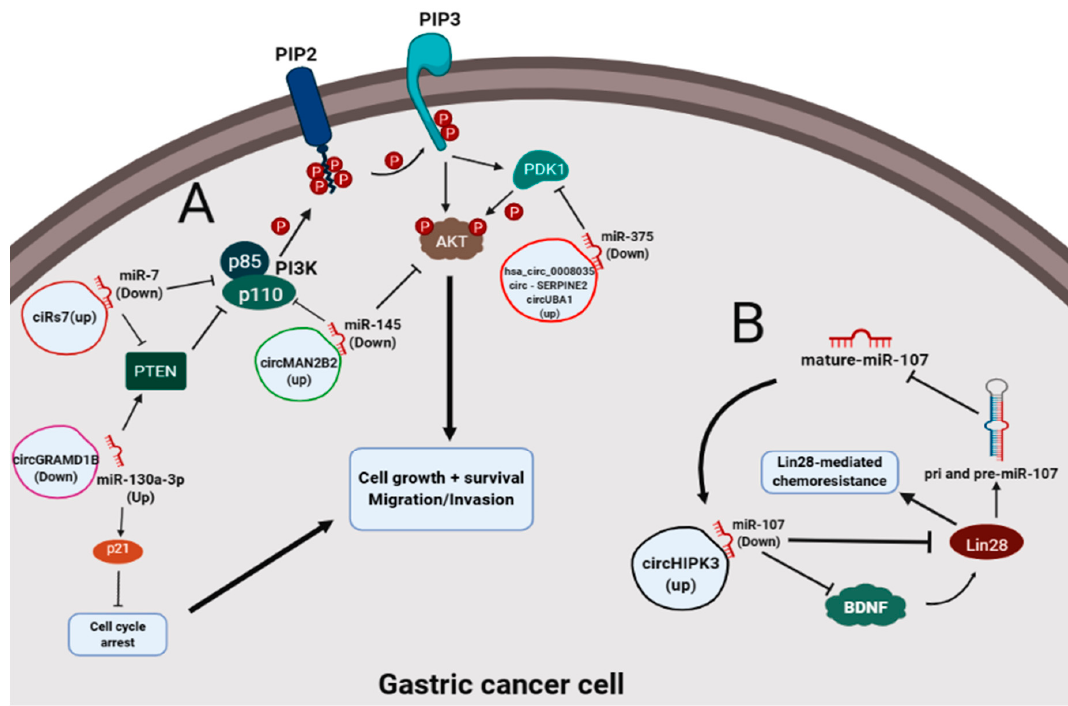
Figure 5. Graphic representation of signaling pathways that promote gastric cancer. ( A ) circRNA- miRNA interactions that affect the PI3K/Akt signaling pathway in gastric cancer. ( B ) circHIPK3/miR- 107/Lin28-mediated chemoresistance of gastric cancer cells.